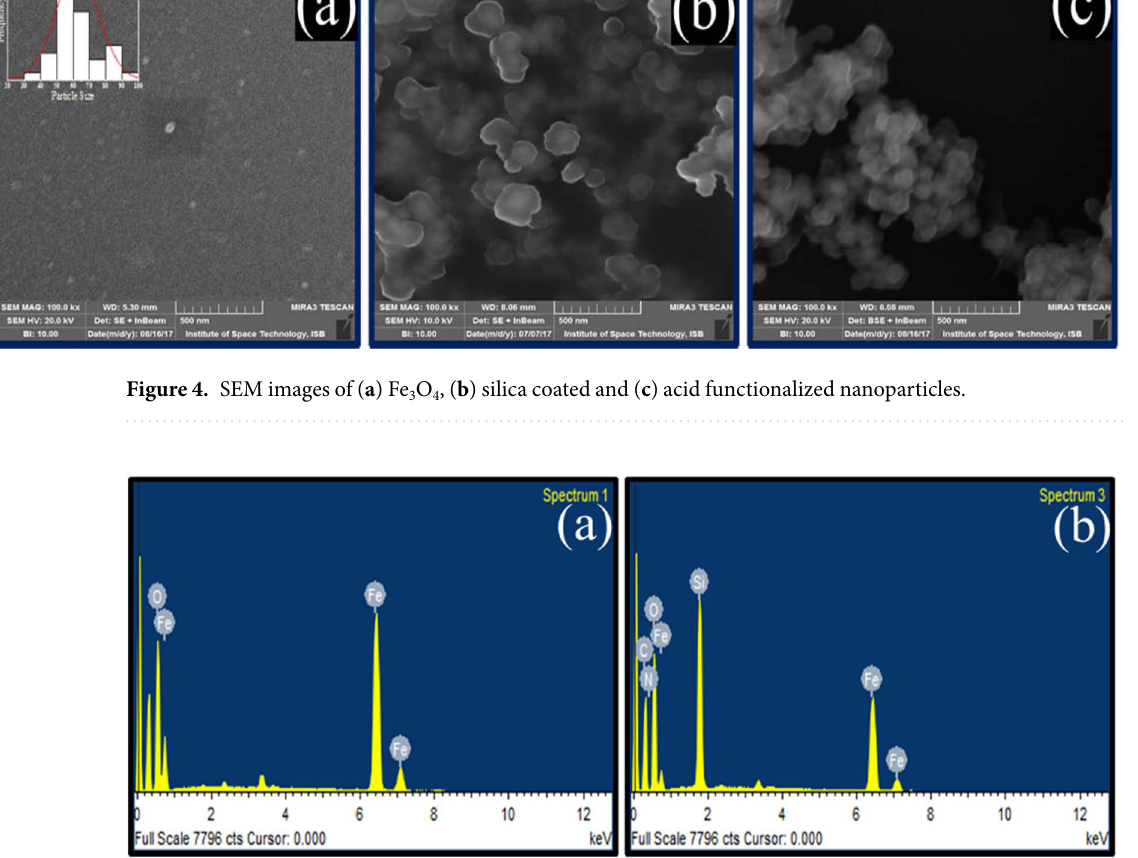
Figure 5. EDS spectra of ( a ) Fe 3 O 4 and ( b ) acid functionalized nanoparticles.